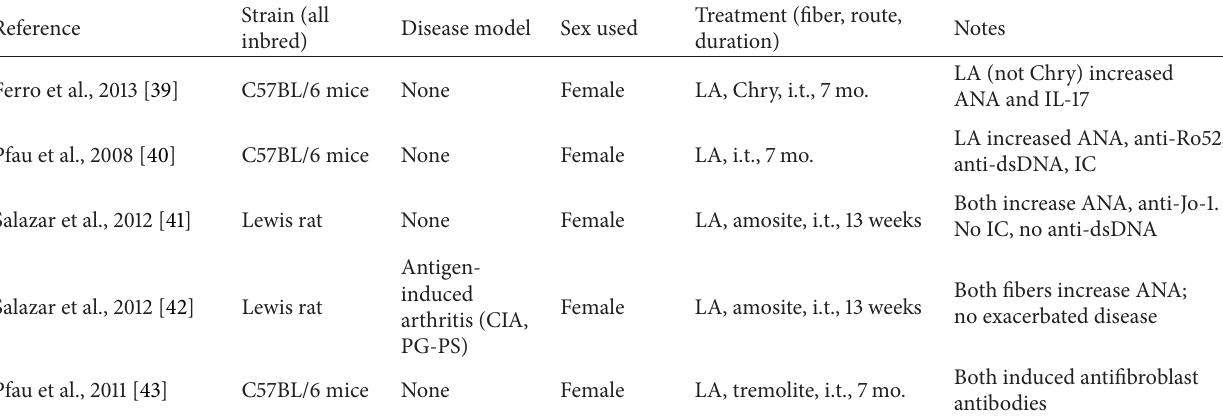
Table 3: Animal model studies of asbestos and